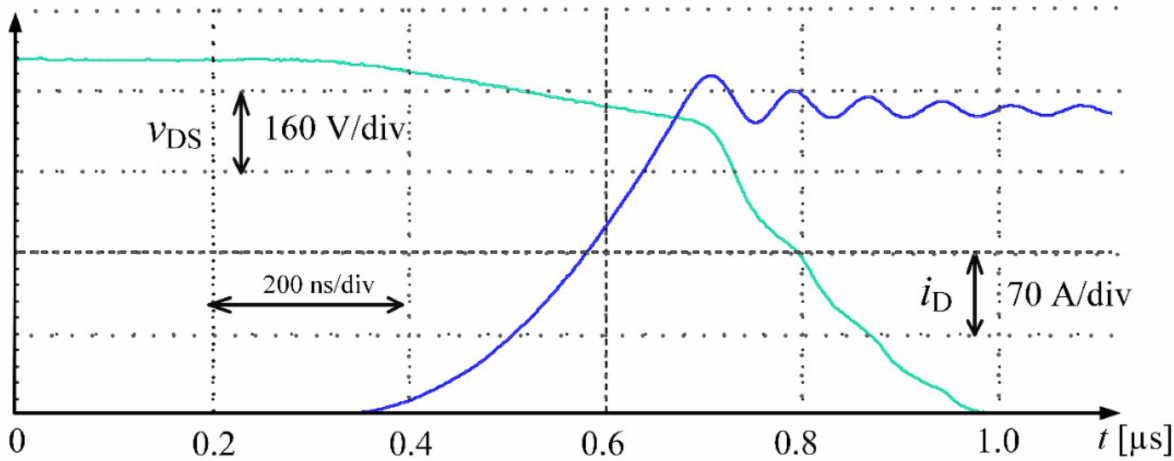
Figure 10. The turn-on cycle of the SiC MOSFET from module CAS300M17BM2 with CGD. V DD = 700 V, I 0 = 270 A.